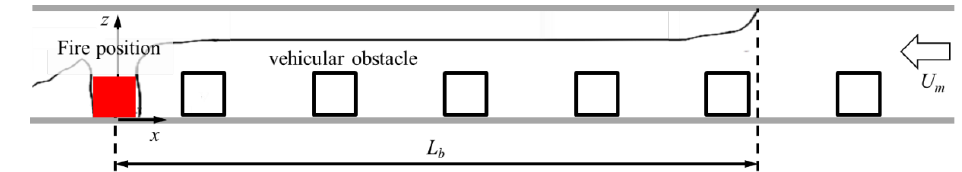
Figure 6. Schematic diagram of the definition of L b of the vehicular blockage in the x – z section view.